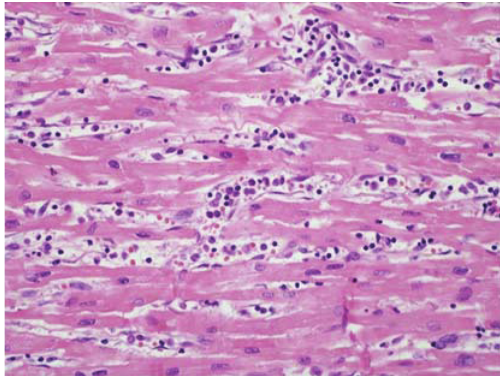
Figure 1: Antibody-mediated rejection characterized by endothe- lial cell swelling and numerous macrophages filling vascular spaces.